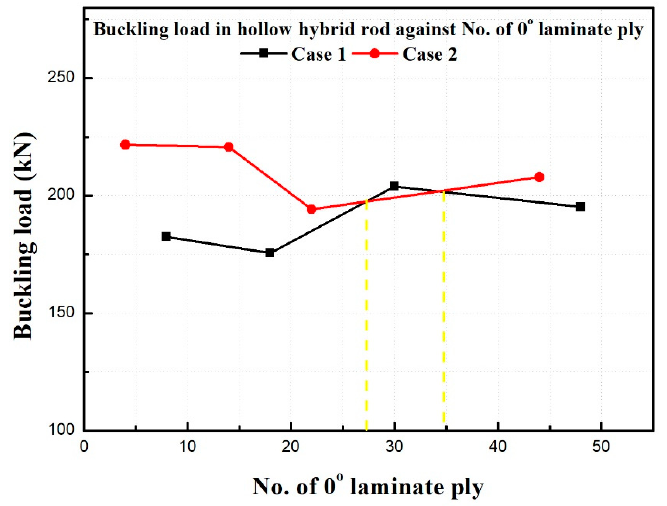
Figure 12. Variation of buckling load as a function of the number of 0° plies in CFRP.